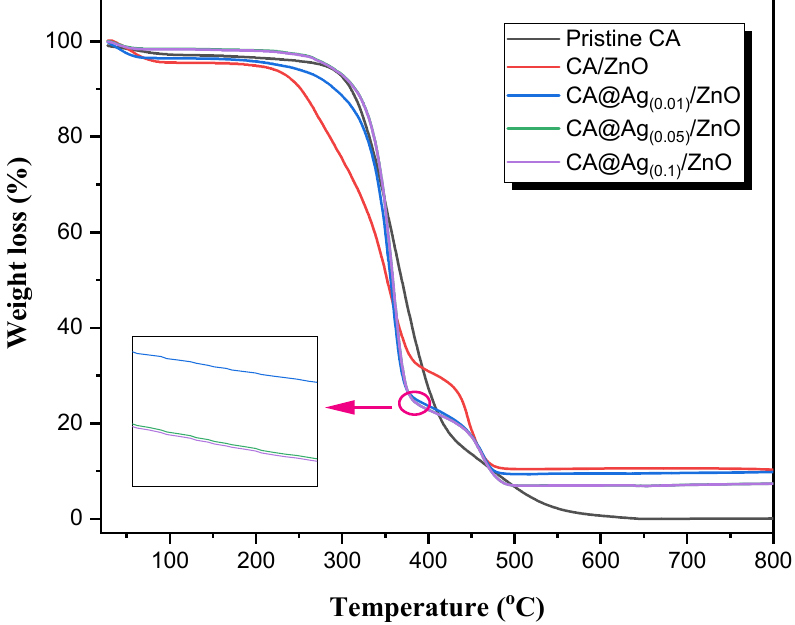
Figure 5. TGA thermograms of pristine CA, CA/ZnO and CA@Ag (0.01, 0.05, 0.1) /ZnO hybrid materials.